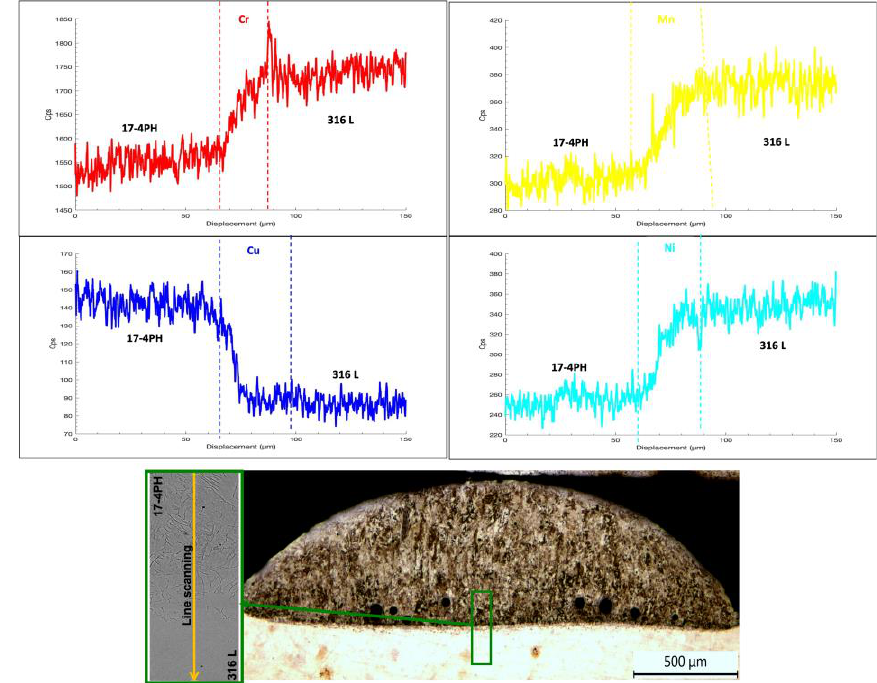
Figure 11. Chemical dilution: SEM/EDS line maps of elements in sample S4_A_2.